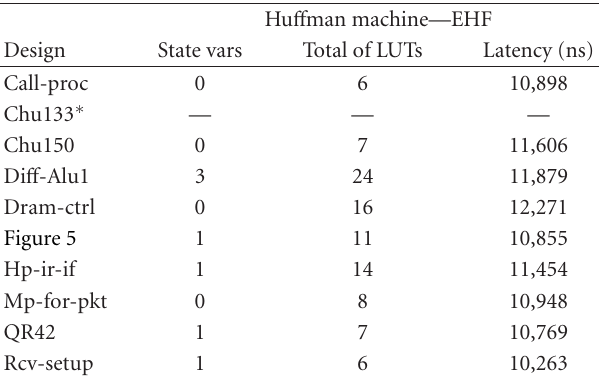
Table 4: Experimental results show Hu ff man machine—EHF ( ∗ Minimalist Tool did not complete the